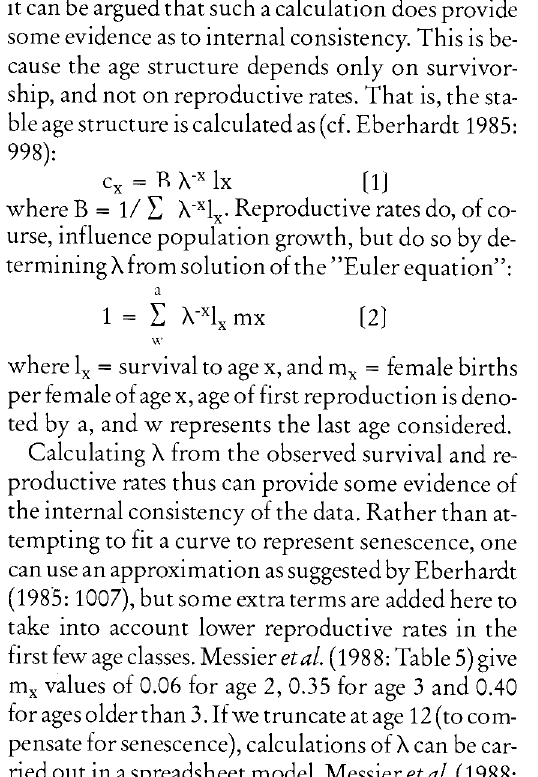
Table 2. Entries for a spreadsheet model for eq. (1), based on data from Tb omas and Barry (1990 a,